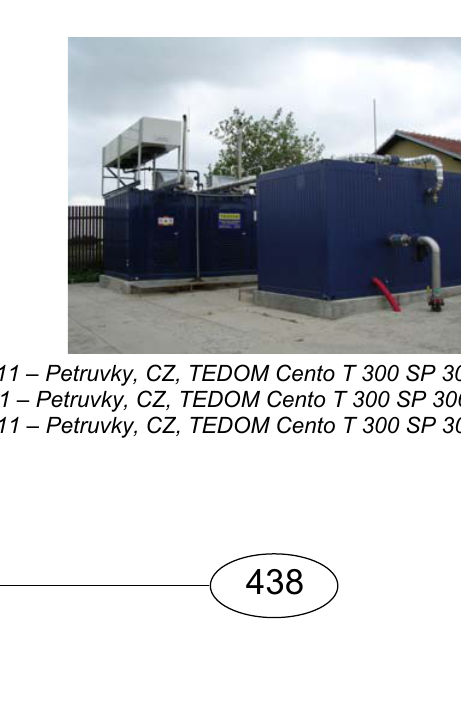
Figure 10 – Modlany, CZ, TEDOM Cento 150 SP BIO 150 kWe, 192 kWt Рис . 10 – Modlany, CZ, TEDOM Cento 150 SP BIO 150 kWe, 192 kWt Слика 10 – Modlany, CZ, TEDOM Cento 150 SP BIO 150 kWe, 192 kWt